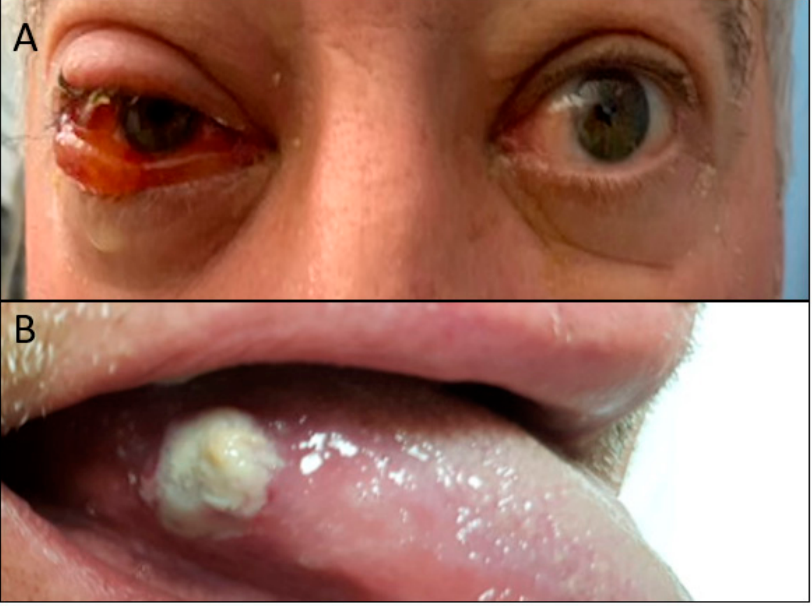
Figure 1. ( A ) Right peri-orbital edema and conjunctival injection at presentation; ( B ) The circular 1 cm × 1 cm white lesion on his lateral right tongue at presentation.